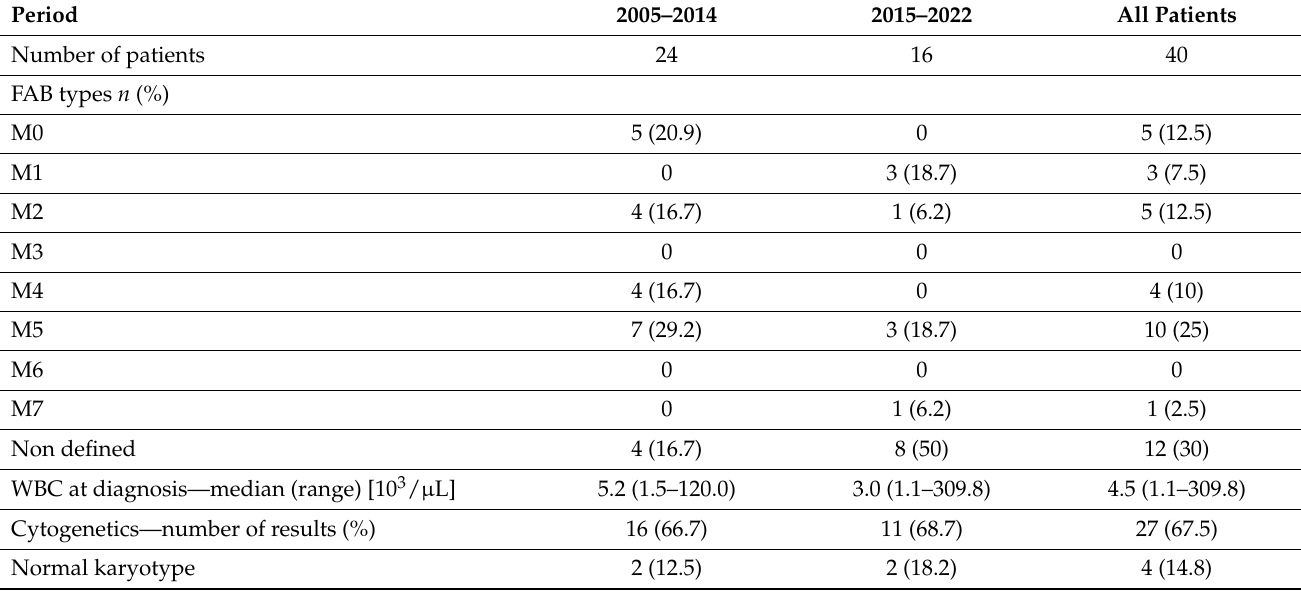
Table 4. Acute myeloid leukemia post cytotoxic therapy